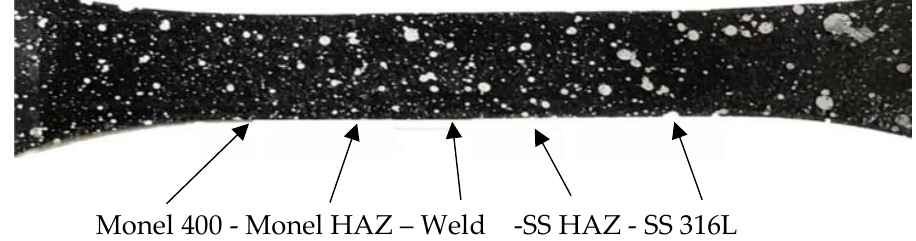
Figure 7. Speckle pattern on specimen.